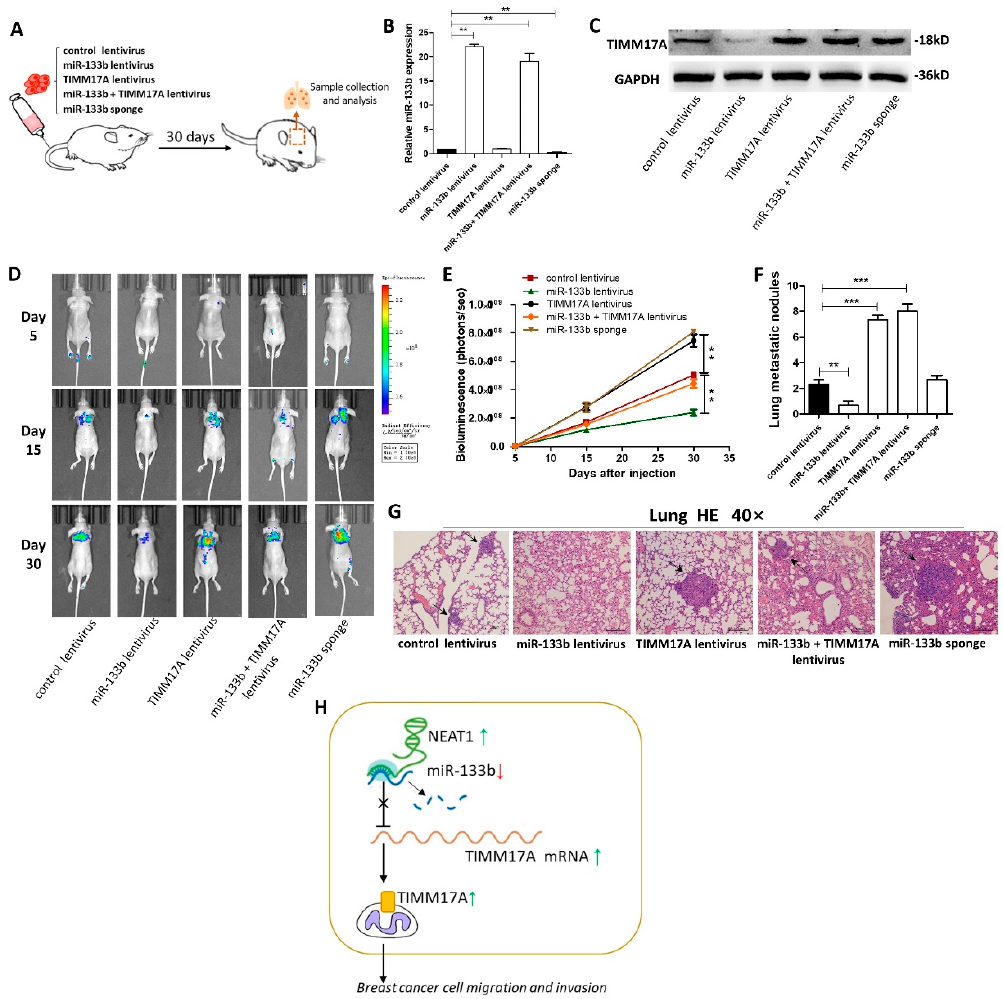
Figure 6. E ff ects of TIMM17A-targeted miR-133b on the lung and liver colonization of MDA-MB-231 cells xenografts in mice. ( A ) Experimental design: immunocompromised mice were injected through tail vein with MDA-MB-231 cells transfected with either the control lentivirus, miR-133b lentivirus, TIMM17A lentivirus, miR-133b lentivirus plus TIMM17A lentivirus, or miR-133b sponge. ( B , C ) miR-133b levels ( B ) and TIMM17A protein levels ( C ) in MDA-MB-231 cells transfected with either the control lentivirus, miR-133b lentivirus, TIMM17A lentivirus, miR-133b lentivirus plus TIMM17A lentivirus, or miR-133b sponge. ( D , E ) Representative BLI images ( D ) and quantitative analysis of the fluorescence intensities ( E ) of mice of five groups. The BLI was performed on days 5, 15, and 30 after injection. The intensity of BLI is represented by the color. ( F , G ) Numbers of metastatic nodules( F ) and representative H&E-stained sections of lung tissues isolated from the intravenously injected mice. Black arrows indicate metastatic nodules. ( H ) A working model for the role of NEAT1-silenced miR-133b in breast cancer metastasis. During breast tumorigenesis, silencing of miR-133b mediated by NEAT1 facilitated migration and invasion of breast cancer cells through up-regulating the expression of TIMM17A. Scale bar, 200 µ m. ** p < 0.01; *** p < 0.001.